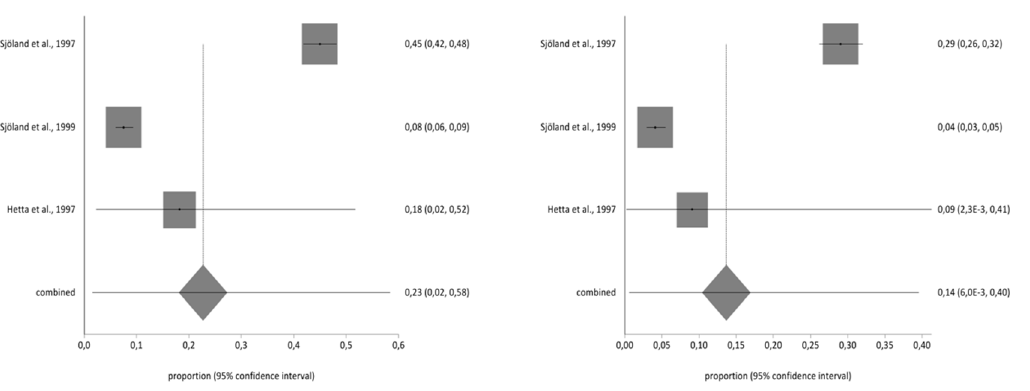
Figure 6. Pre- and post-impact on sex life.